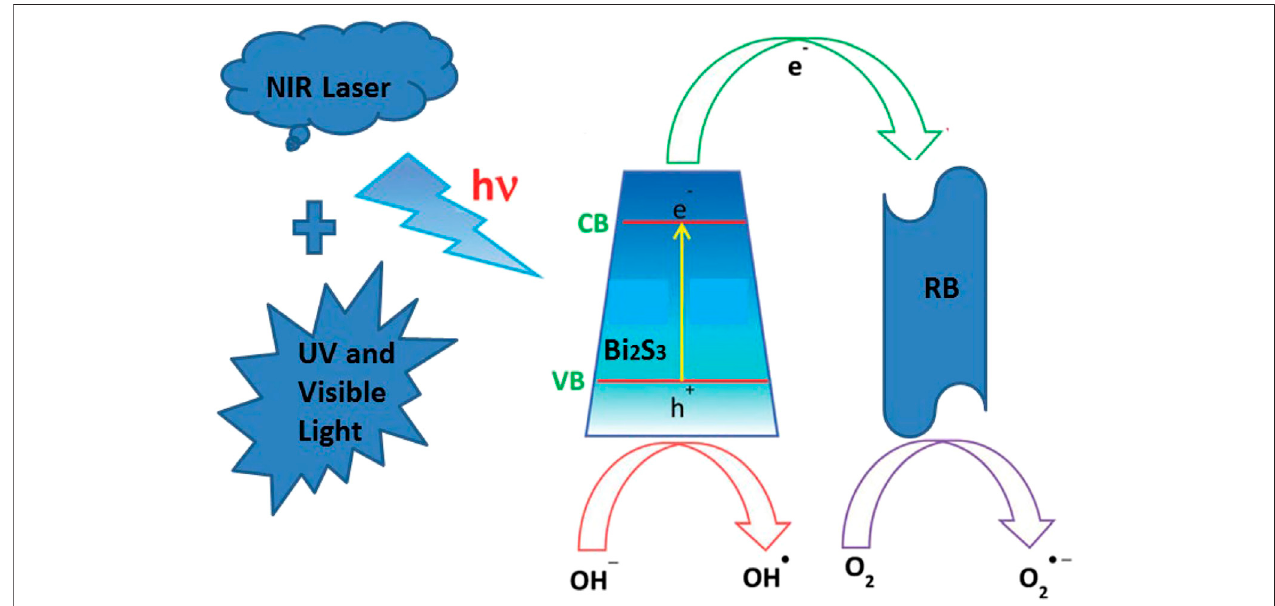
FIGURE 7 | The degradation of MB in the Bi 2 S 3 NPs in aqueous solution, the absorption value was measured with different treatment (0, 3, 6, and 9 min).